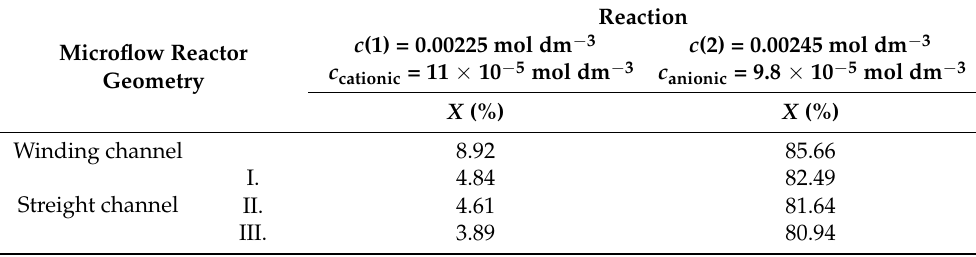
Table 2. Comparison of conversions obtained in different microflow reactors for the residence time of τ = 0.2